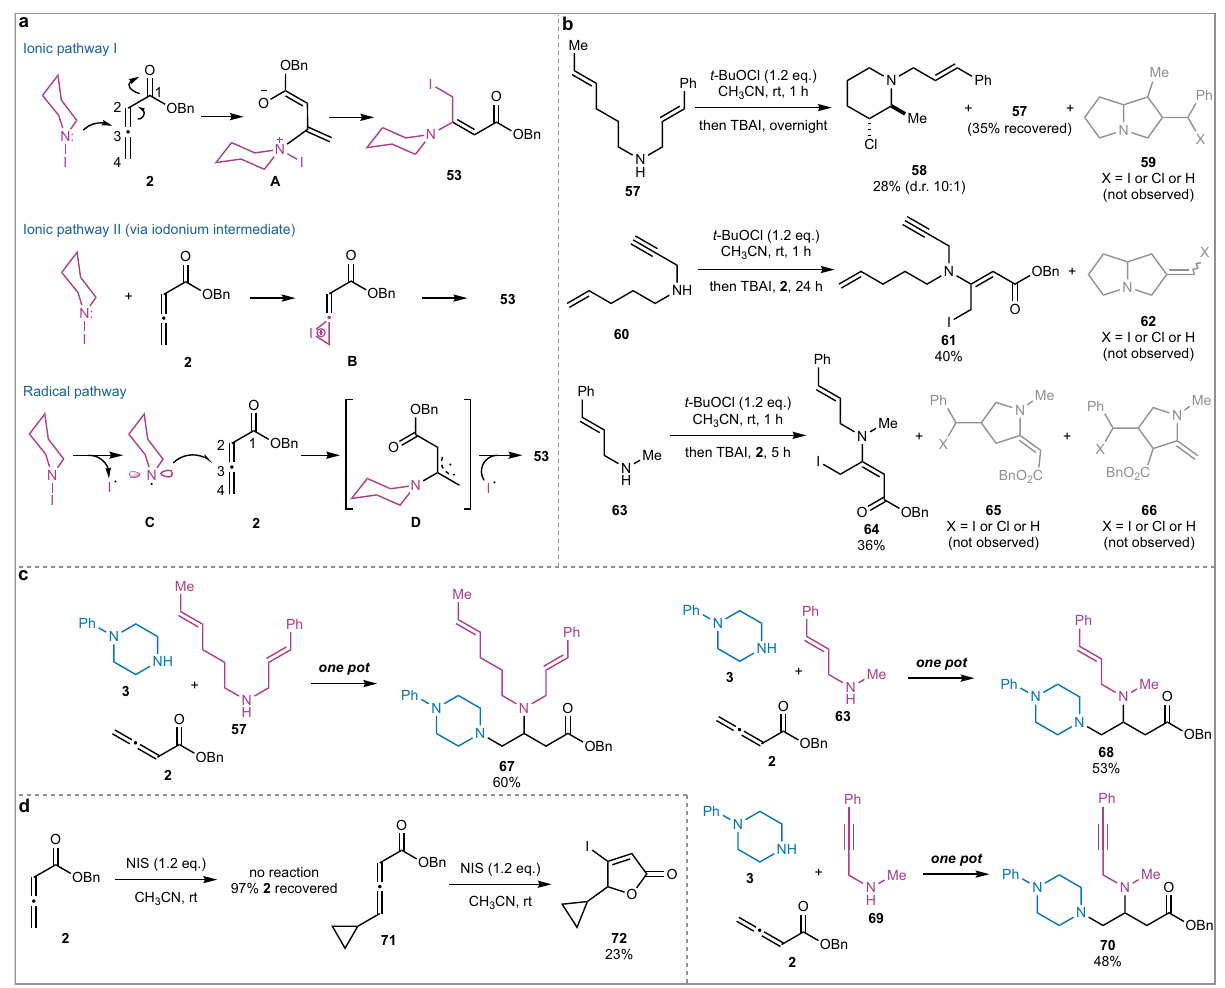
Fig. 5 | Mechanistic studies. a Proposed reaction mechanism. b Radical trapping experiments with tethered alkenes and alkynes. c Results of substrates 57 , 63 , and